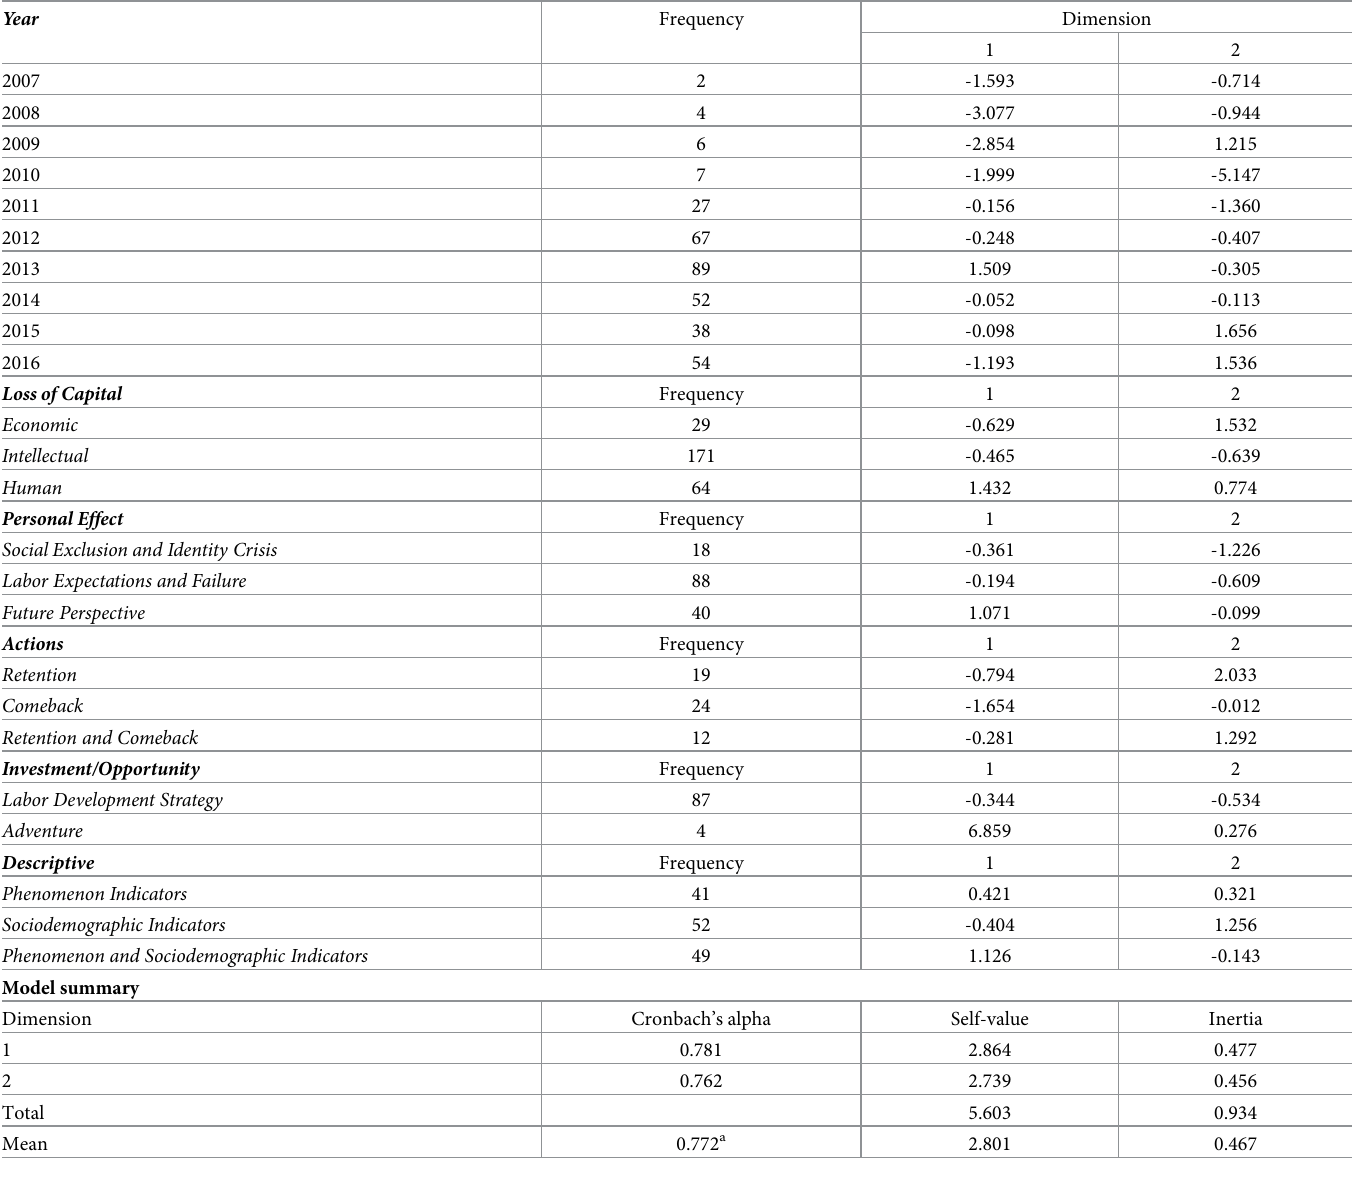
Table 12. Correspondence coordinates between assessment of the phenomenon and